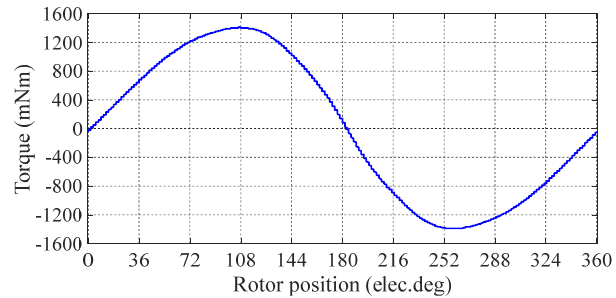
Figure 1. Testing result: the TAC of the motor.